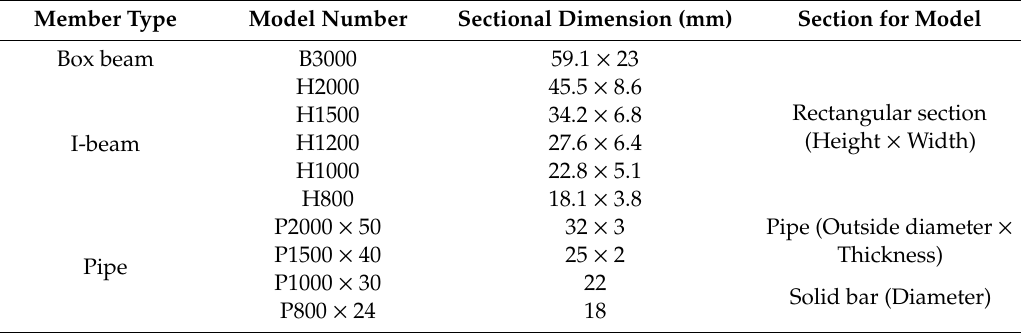
Table 2. Geometric dimension parameters of the superstructure model.